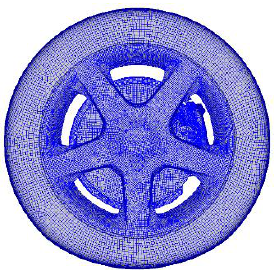
Figure 3. Typical thermal model of a brake assembly including wheel rim and tire.